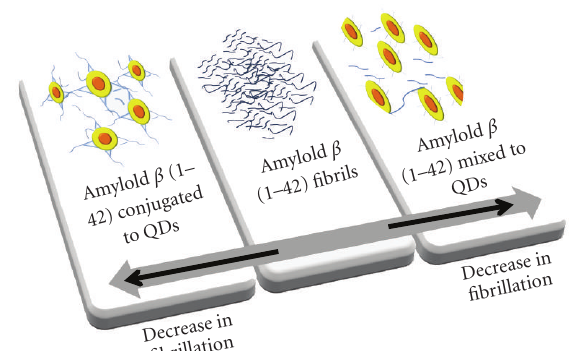
Figure 12: Diminution of fibrillation process in presence of DHLA- capped